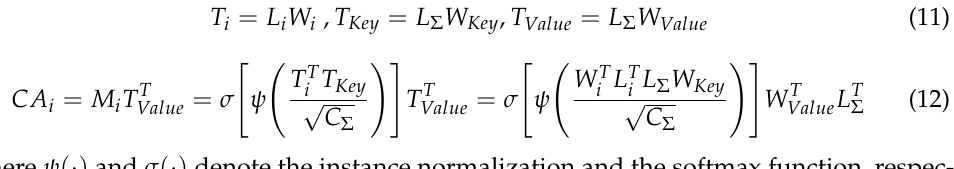
Multi-Layer Perceptron (MLP). After the multiple cross-notice mechanisms, the re- sults are fed into the MLP with the residual structure and residual operator to obtain the output. An L-layer transformer is constructed by repeating the operation equation (14) L times. The four outputs O 1 , O 2 , O 3 , O 4 of the L-th layer are reconstructed by